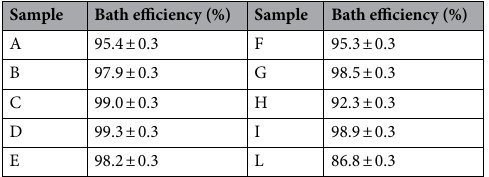
Table 1. Percentage efficiency of each electroplating bath estimated by gravimetric analysis.